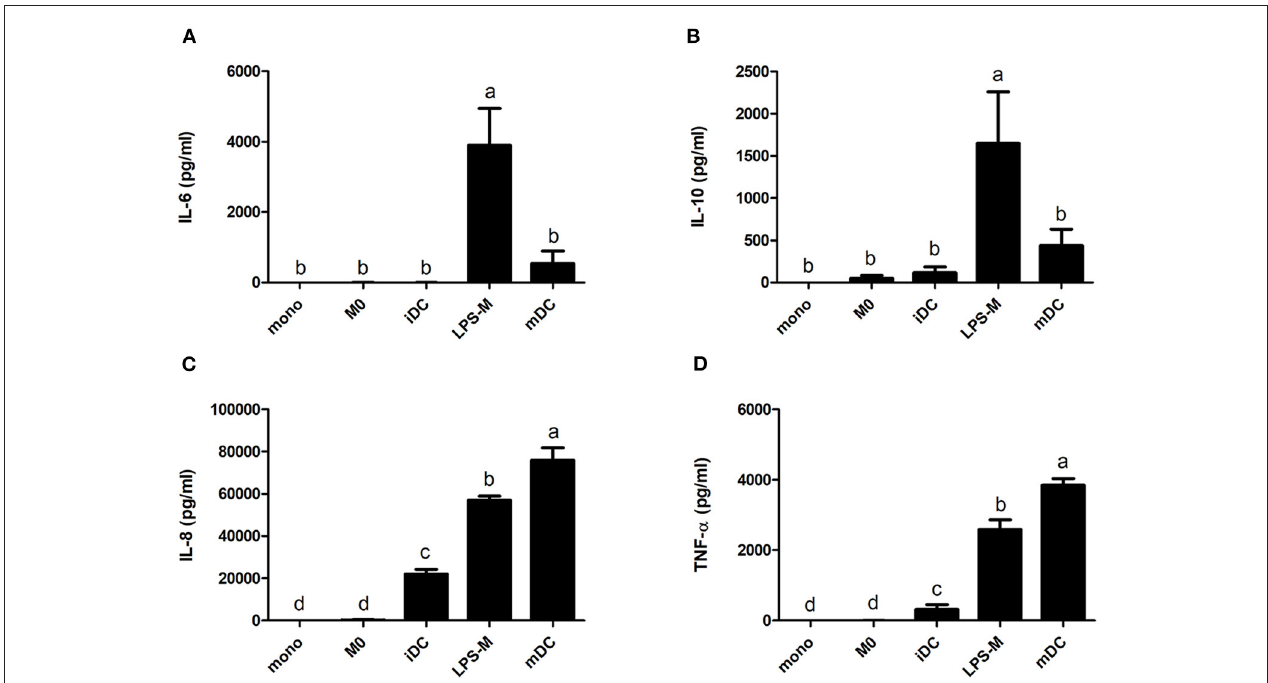
FIGURE 5 | LPS-mediated activation resulted in significantly different increases of cytokine production for THP-1-derived macrophage- (M0) and dendritic-like cells (iDC). THP-1 monocytes were non-treated or differentiated into M0 and iDC and stimulated with LPS. The supernatant of the cell cultures was collected, and the cytokines levels of IL-6 (A) , IL-10 (B) , IL-8 (C) , and TNF- α (D) were determined using ELISA. The results represent mean values ± SD of 2–4 independent experimental measurements. The statistical differences were calculated with Fishers Least Significant Difference (LSD) test and bars with different letters represent significant differences ( p < 0.05).